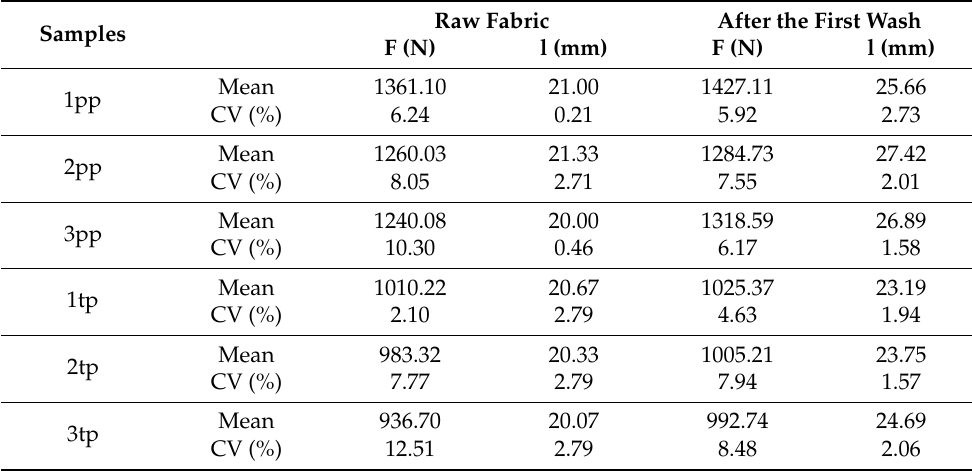
Table 7. Results of measuring breaking strength by bursting with a steel ball.